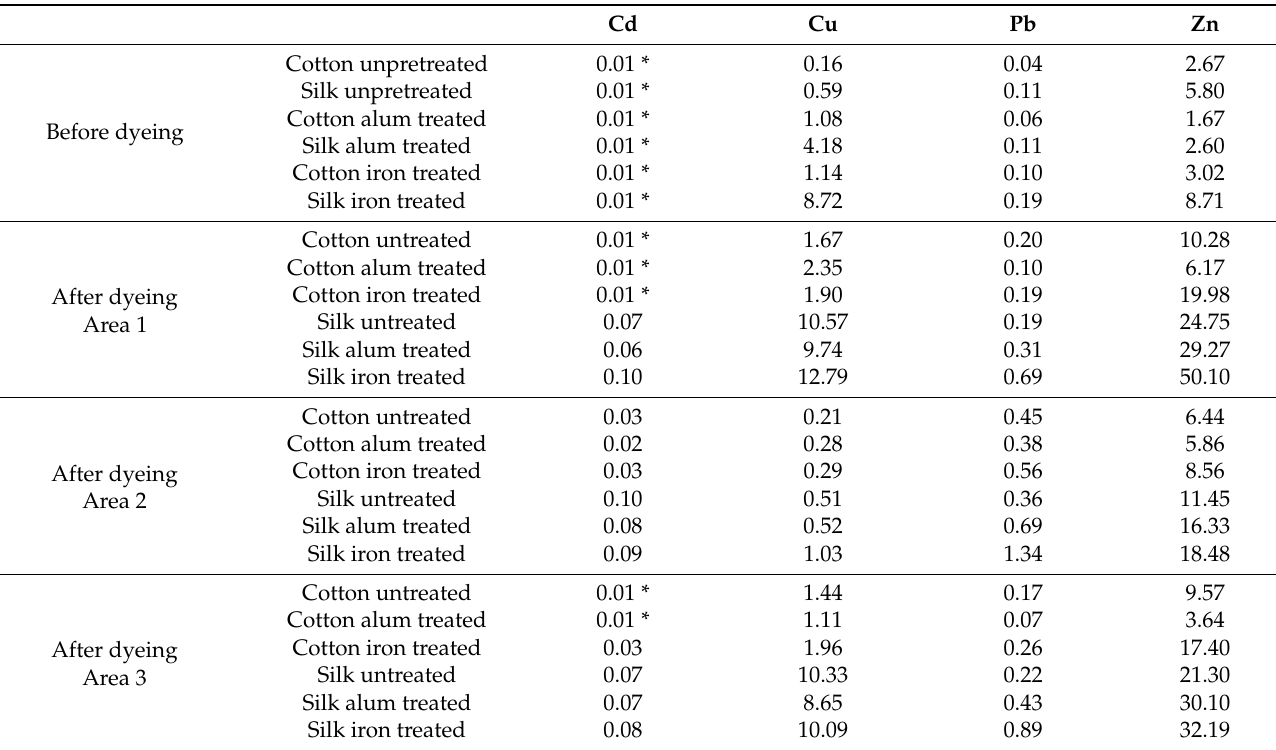
Table 6. TE concentration ( µ g g − 1 ) in the fabrics (cotton and silk) before and after dyeing according to the area and the pretreatment modalities ( n =